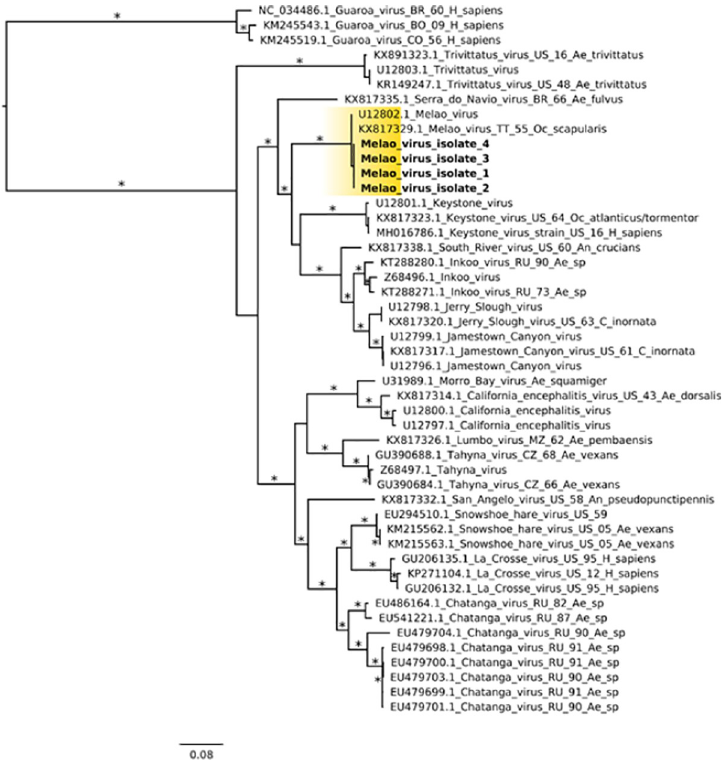
Fig 4. Maximum likelihood (ML) tree based on the Small genome segment of MELV and other California serogroup orthobunyavirus isolates. MELV isolates from this study are highlighted in yellow color; GenBank accession numbers for the corresponding small genome sequences are: 1 (MN264272); 2 (MN268724), 3 (MN268727), and 4 (MN268730). Asterisks represents Shimodaira-Hasegawa (SH-like) support values equal or greater than 75%. Branch lengths are drawn in scale of nucleotide substitutions per site according to the bar in the figure. Abbreviations: BR, Brazil; BO, Bolivia; CO, Colombia; CZ, Czech Republic; MZ, Mozambique; RU, Russia; TT, Trinidad and Tobago; US, United States. Mosquito genera: Ae ., Aedes; An ., Anopheles; C ., Culiseta; Oc ., Ochlerotatus